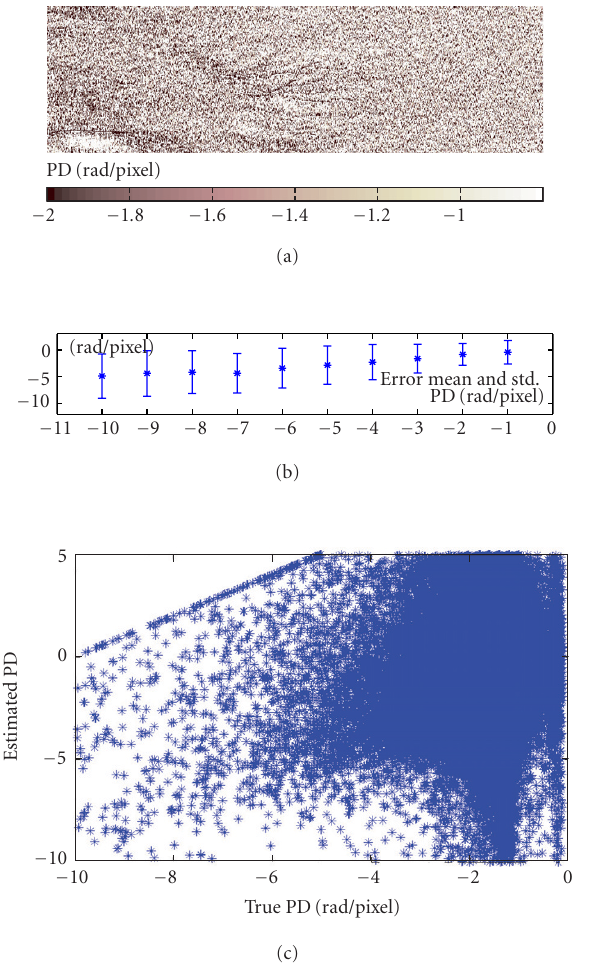
Figure 8: The same as Figure 7, but with the application of the CB with respect to the flat Earth.